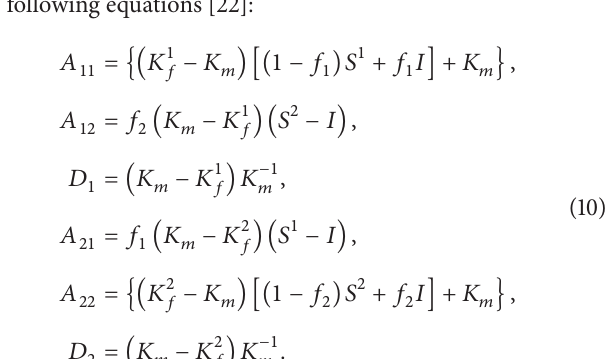
Figure 2: MEM for equivalent thermal conductivity in composite.